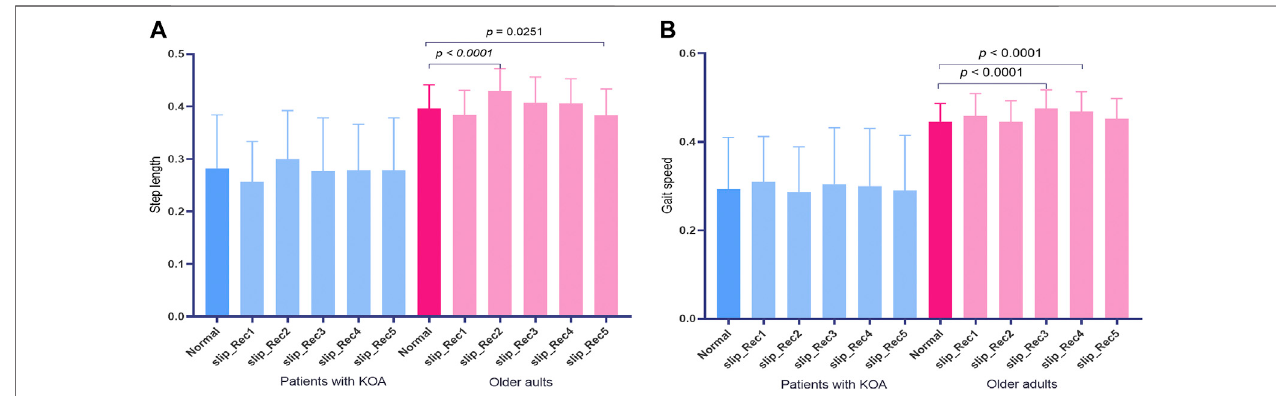
FIGURE 2 | The step length (A) and gait speed (B) in normal walking (Normal) and the fi ve steps following the perturbation. Blue bars indicate patients with knee osteoarthritis (KOA) and red bars indicate older adults.